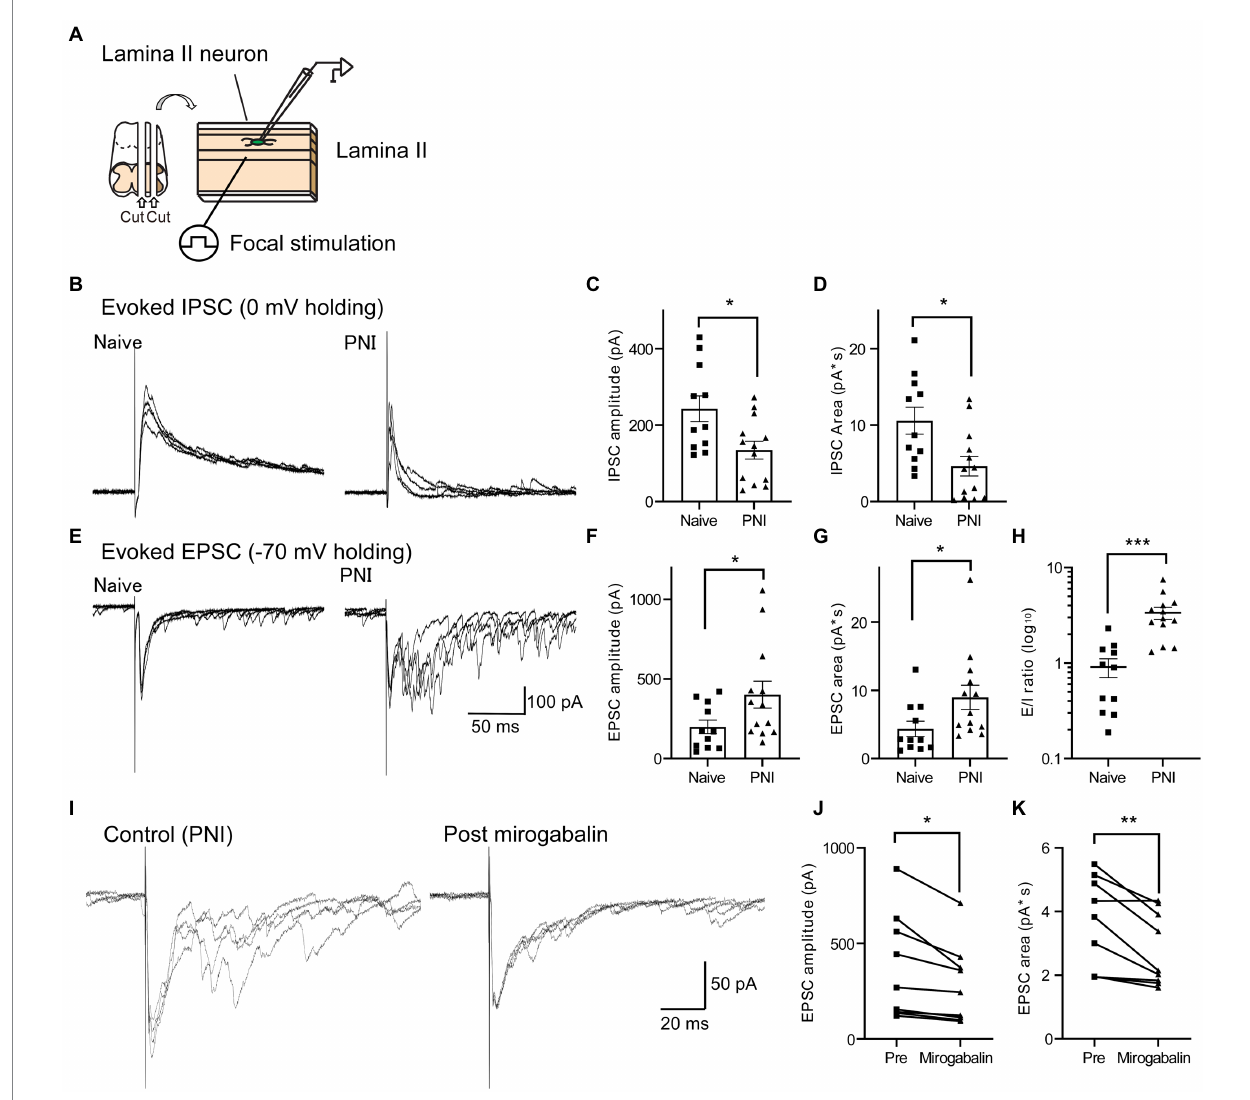
FIGURE 3 EPSCs and IPSCs in SDH neurons were increased or decreased, respectively, after PNI. (A) Schematic of the whole-cell patch-clamp recording from SDH neurons and electrical focal SDH stimulation. (B) Representative traces of evoked IPSCs in SDH neurons of naïve (left) or PNI (day 6–10, right) mice. (C,D) Summary of IPSC amplitude of naïve and PNI mice [ C ; n = 11 (naïve), n = 13 (PNI), unpaired t -test, t = 2.69, df = 22, * p < 0.05] and IPSC area [ D ; n = 11 (naïve), n = 13 (PNI), unpaired t -test, t = 2.79, df = 22, * p < 0.05]. (E–G) Same as (B–D) but those of evoked EPSC in the same recorded